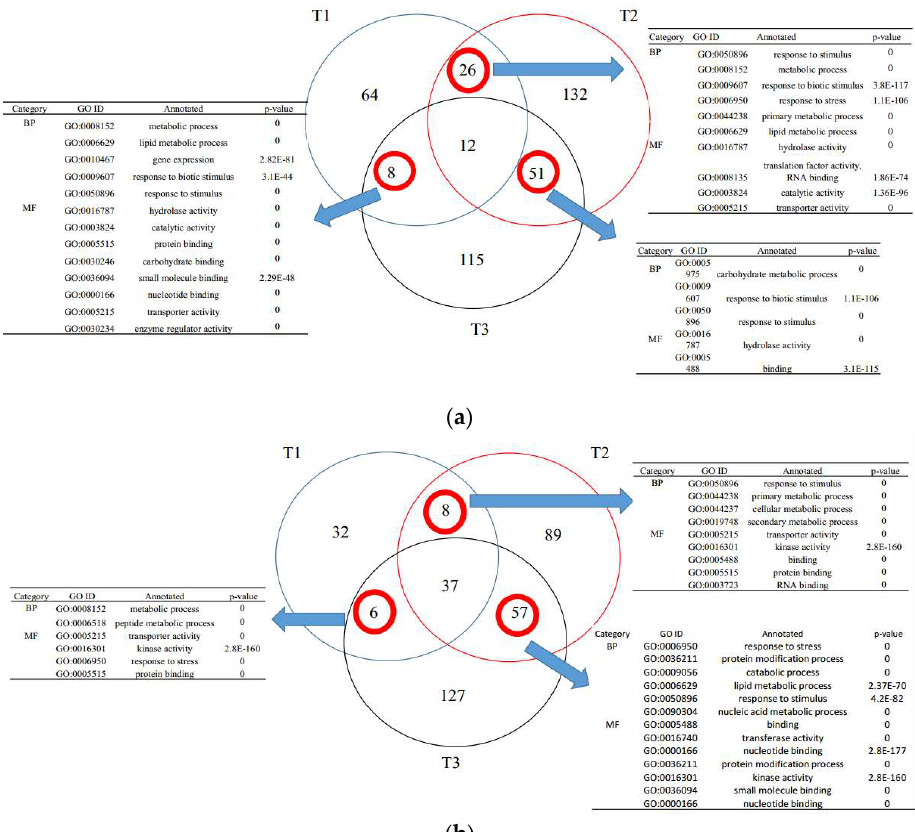
Figure 1. Distribution of differentially expressed proteins. ( a ): The up-regulated expression in watermelon response to F1-35 at 12, 24, and 48 hpi. ( b ): The down-regulated expression in watermelon response to F1-35 at 12, 24, and 48 hpi. T1: CK treatment at 12 hpi; T2 : CK treatment at 24 hpi; T3 : CK treatment at 48